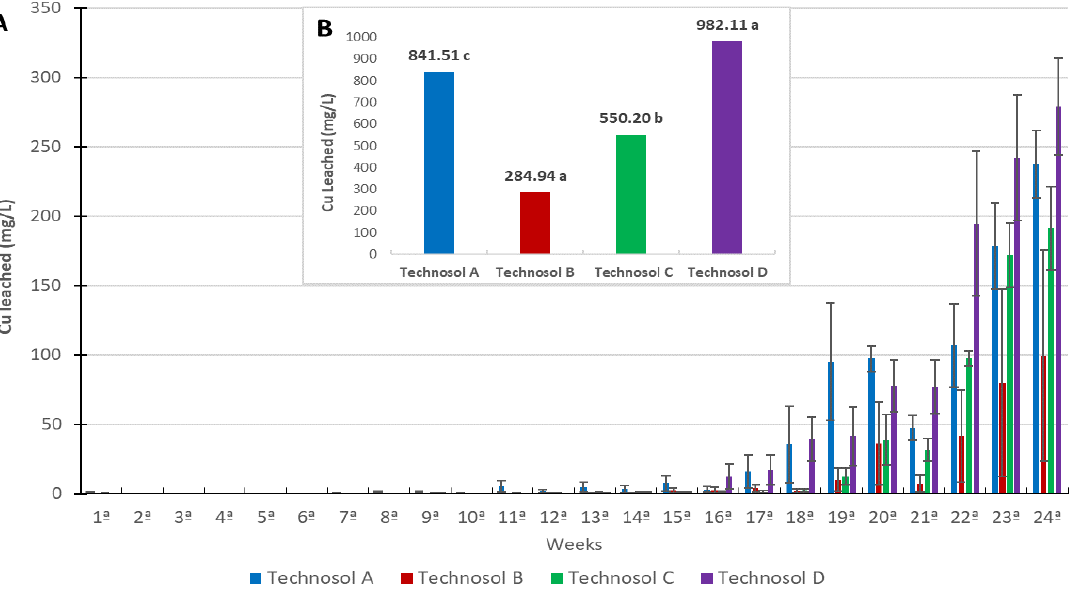
Figure 3. ( A ) Copper leached during the 24-weeks period of experiment. ( B ) Total Cu leached after 24-weeks. Values indicated by same letters in columns do not differ according to the Tukey test ( p < 0.05).